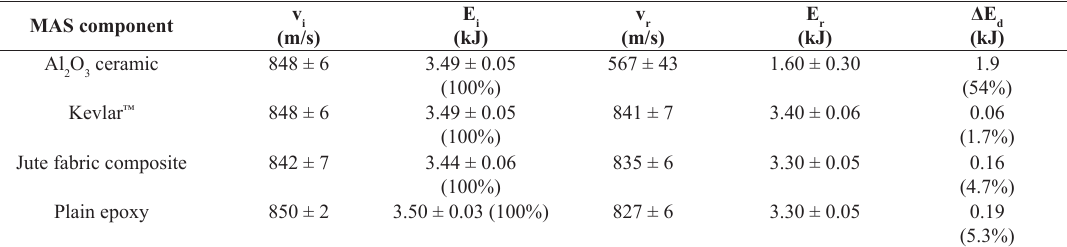
Table 2. Impact and residual velocities together with internally dissipated energy in individually ballistic tested MAS components. MAS component